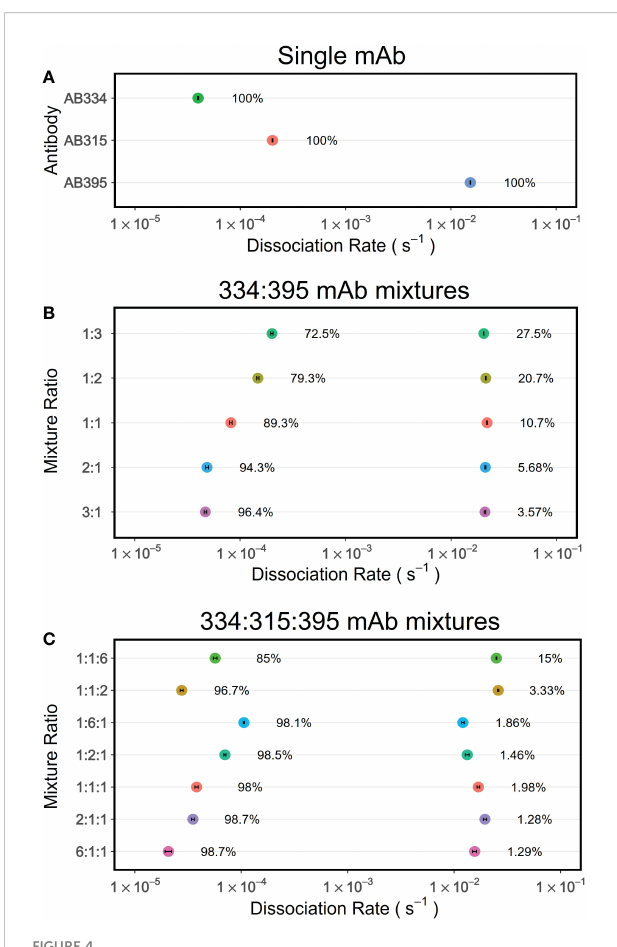
FIGURE 4 PAART analyses of dissociation phases of mAbs mixtures interacting with NPNA3 dissect different dissociation rates. The dissociation rates and their fractions estimated by PAART analysis of dissociation phases of mAbs alone (A) , the binary mixtures of AB334 and AB395 at various compositions (B) and the ternary mixtures of AB334, AB315 and AB395 (C) at different compositions are shown. The dissociation phases used here were recorded after 5 minutes of association phase. In each panel, the error bars associated with symbols indicate the standard error in the estimate of k d